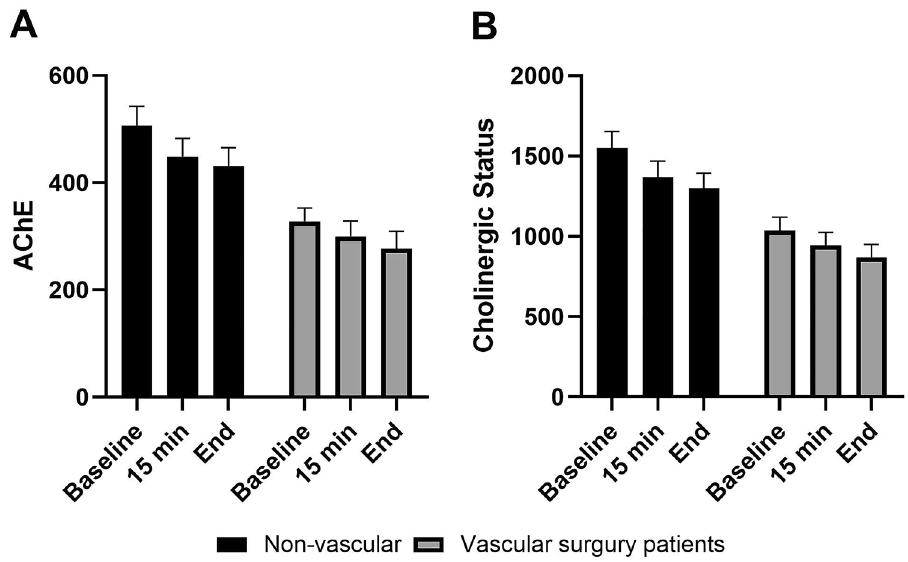
Figure 1. Mean AChE activity ( A ) and total cholinergic status in vascular vs. non-vascular patients by time of measurement during anesthesia (baseline, 15 min and at the end of